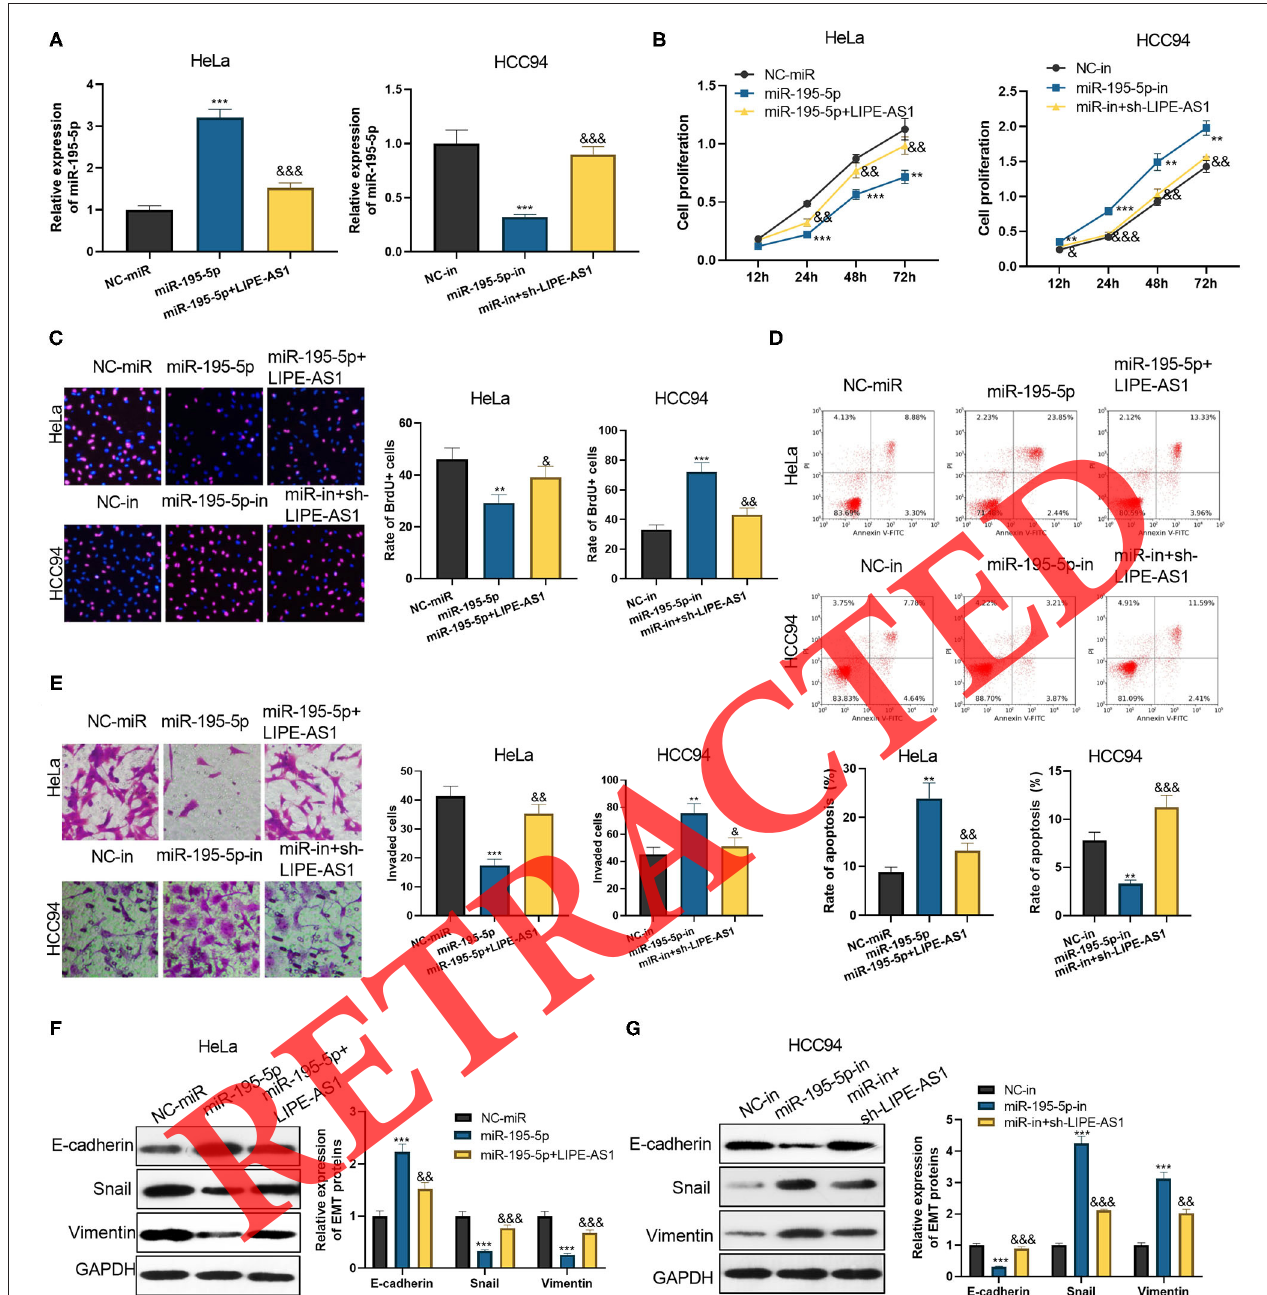
FIGURE 4 | The function of LIPE-AS1/miR-195-5p in cervical cancer cells. (A) MiR-195-5p mimics and inhibitors were taken to construct miR-195-5p over- and down-expressing cell lines, respectively, and further transfected with LIPE-AS1 over-expressed plasmids or sh-LIPE-AS1 to perform compensation experiments. CCK8 method (B) and BrdU method (C) were employed to detect HeLa and HCC94 cell proliferation. (D) Flow cytometry was performed to test the apoptosis of HeLa and HCC94 cells. (E) Transwell method was carried out to examine HeLa and HCC94 cell invasion. The expressions of E-cadherin, Snail, and Vimentin in HeLa (F) and HCC94 cells (G) were examined by Western blot. ** P < 0.01, *** P < 0.001 vs. Vector or sh-NC group. & P < 0.05, && P < 0.01, &&& P < 0.001 vs. LIPE-AS1 group or sh-LIPE -AS1 group. N = 3. miR-195-5p expression while silencing LIPE-AS1 promoted miR-195-5p expression ( Figures 3G–I ). These results identified that miR-195-5p was the target molecule of LIPE-AS1, which may affect as a